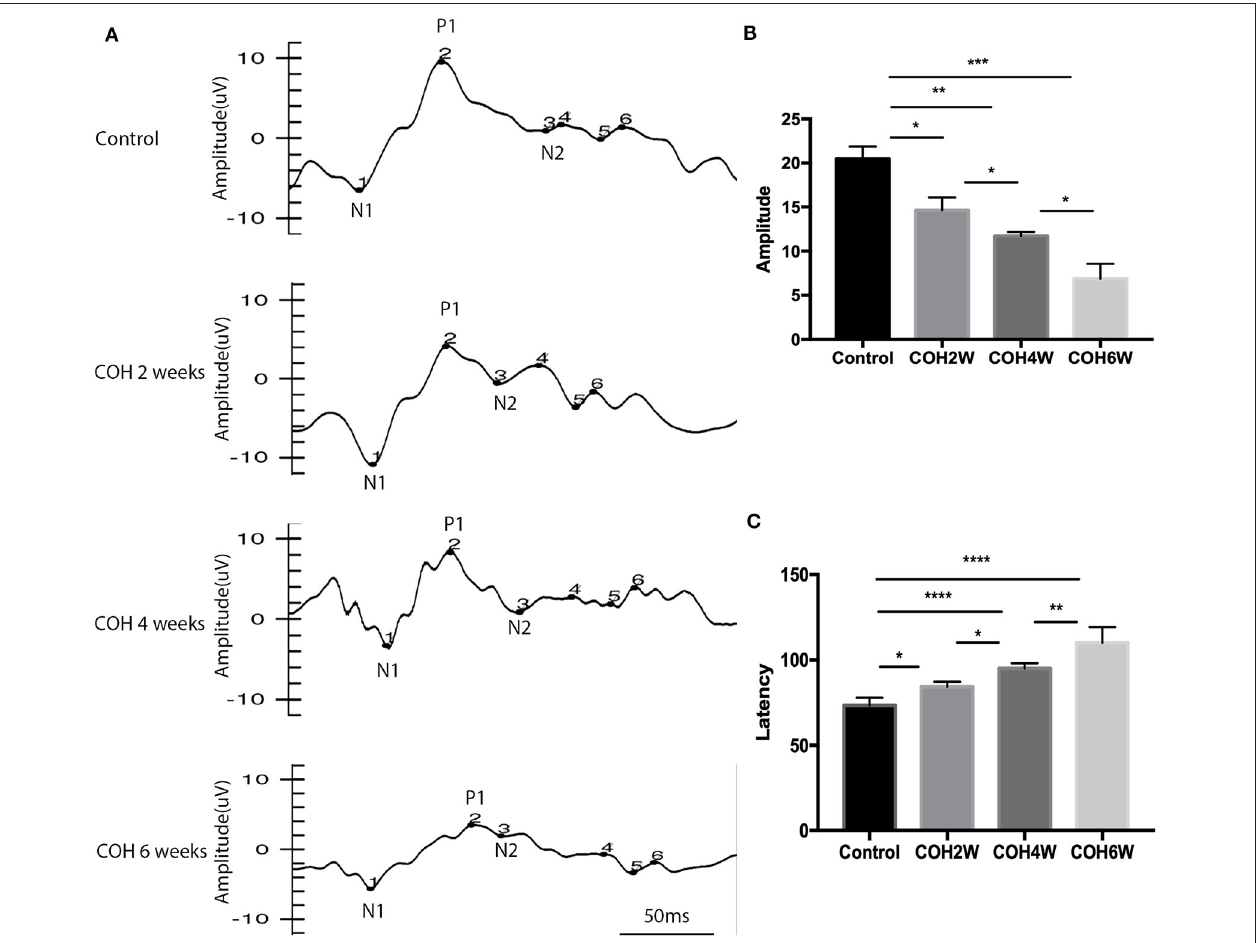
FIGURE 3 | Flash visual evoked potential (F-VEP) test result of C57BL/6J mice. (A) The F-VEP test was measured before and 2, 4, and 6 weeks after IOP elevation induced by intracameral injection of hydrogel. (B) The amplitudes of P1 were significantly reduced in the hydrogel-injected eyes compared with those in the control group. (C) The latent periods of P1 were significantly prolonged in mice at 2, 4, and 6 weeks of COH compared with those in the control group. Data were analyzed using one-way ANOVA followed by Tukey’s post hoc test (* p < 0.05, ** p < 0.01, *** p < 0.001, and **** p < 0.0001). N = 24 mice (control group: 6 mice; hydrogel injection group: 18 mice). Bars represent mean ±